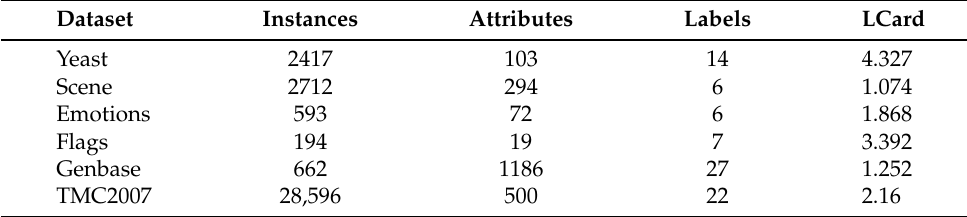
Table 1. Multi-label datasets